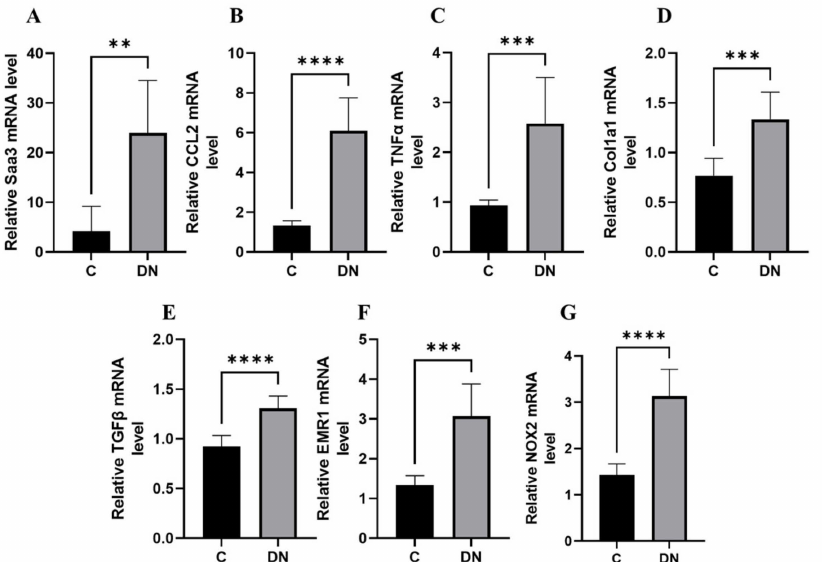
Figure 2. Renal fibro-inflammatory markers are upregulated in HFD/multiple low-dose STZ-induced DN model ( A – G ) Total RNAs in kidney tissues from the HFD/multiple low-dose STZ-induced DN model ( n = 9) were isolated. The relative mRNA expression level of each gene was deter- mined by quantitative PCR and normalized to L19 mRNA level and are presented as means ± S.E. ** p < 0.01, *** p < 0.001, **** p < 0.0001. The data are representative of two independent experiments. DN = Diabetic Nephropathy, C =